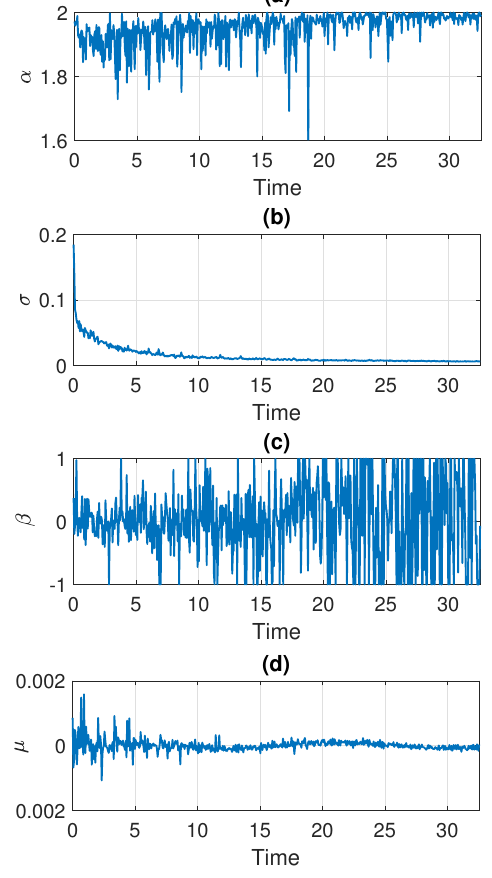
Figure 5. Estimated parameters of the stable distribution for Signal